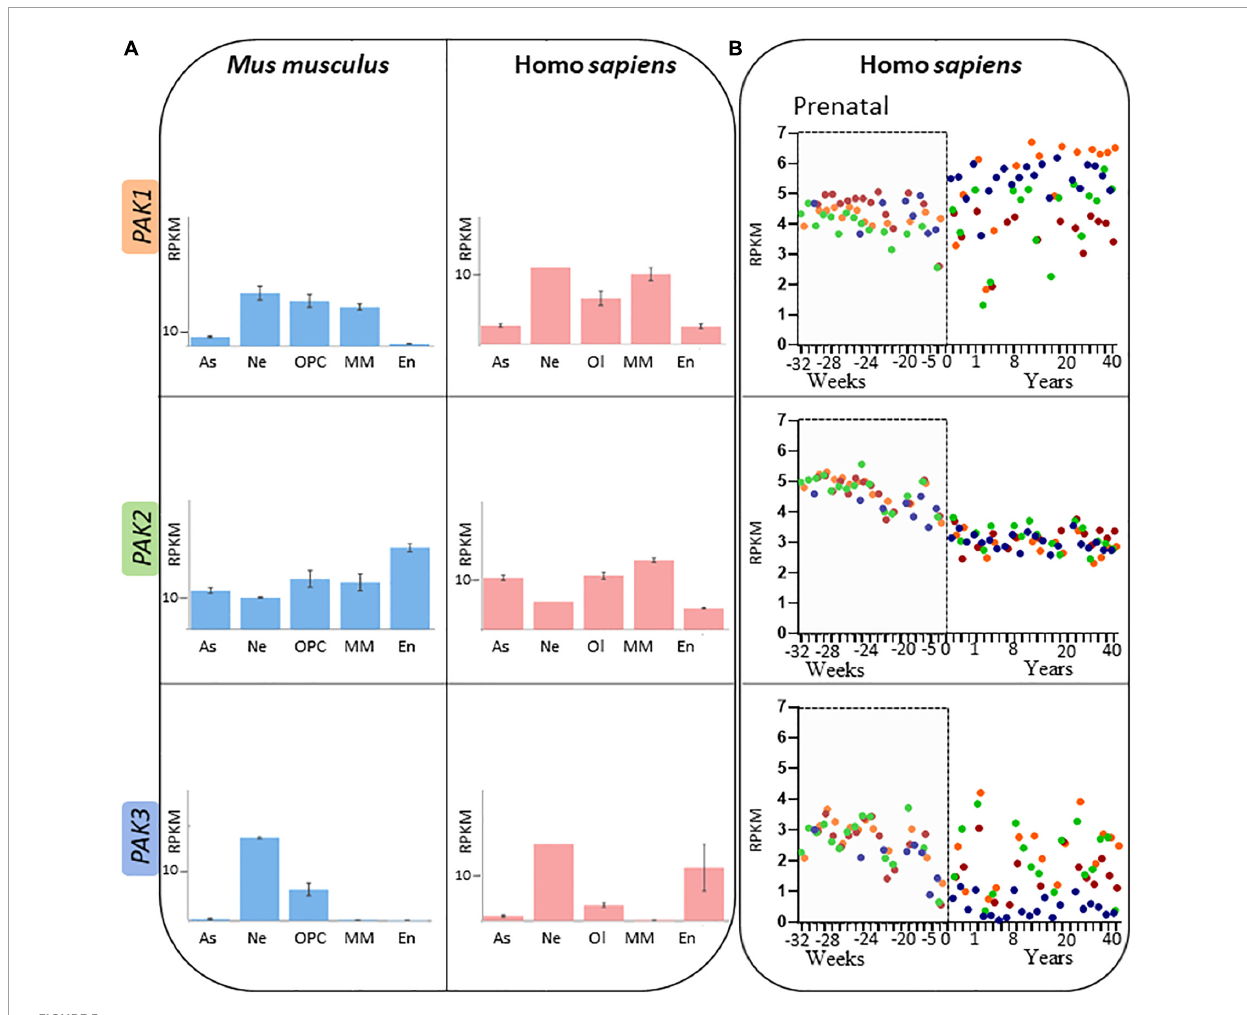
FIGURE5 Spatio-temporal expression patterns of PAK isoforms (A) PAK expression depending on brain cell types, expressed in RPKM (reads per kilobase of exon per million reads mapped) in adult mouse (blue) and human (pink). Astrocytes (As), neurons (Ne), Oligodendrocyte precursor cells (OPC) or Oligodendrocyte (Ol), microglia/macrophages (MM) and endothelial cells (En). Data mining from brainrnaseq.org. (B) PAK expression throughout human lifespan in neurons of the cerebellar cortex (blue), hippocampus (green), striatum (brown), and frontal cortex (orange). Data mining from